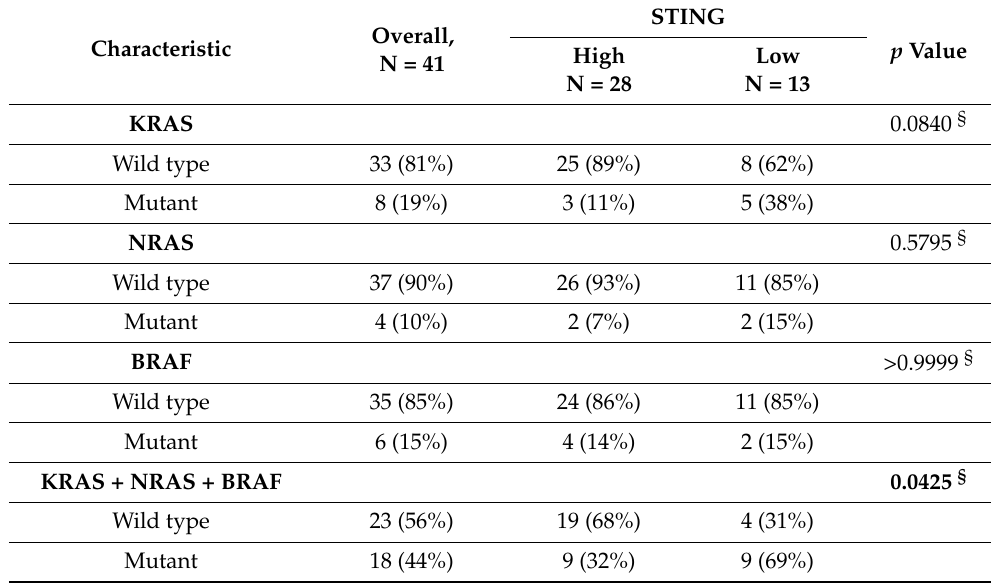
KRAS: V-Ki-Ras2 Kirsten rat sarcoma 2 viral oncogene homolog; NRAS: neuroblastoma RAS viral oncogene homolog; BRAF: v-Raf murine sarcoma viral oncogene homolog B; STING: stimulator of IFN genes. § Fisher’s exact test. The p -value represented in bold is statistically significant.